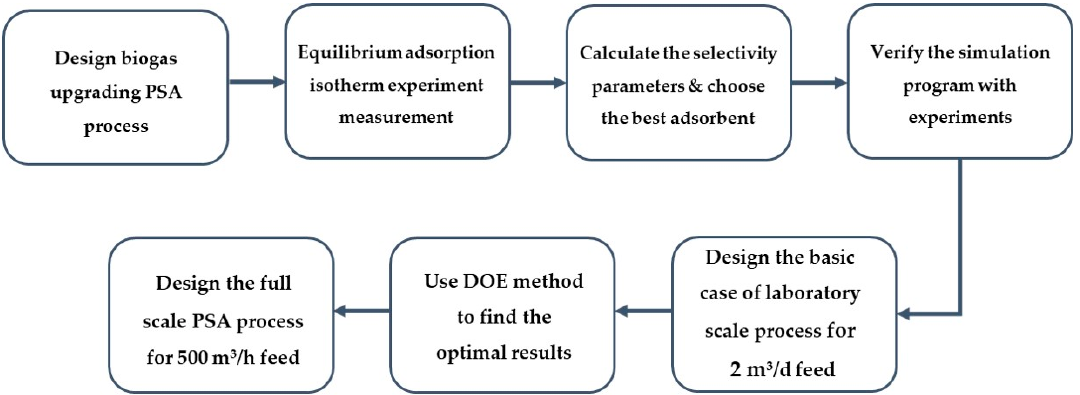
Figure 1. Schematic diagram of flowchart for research design.